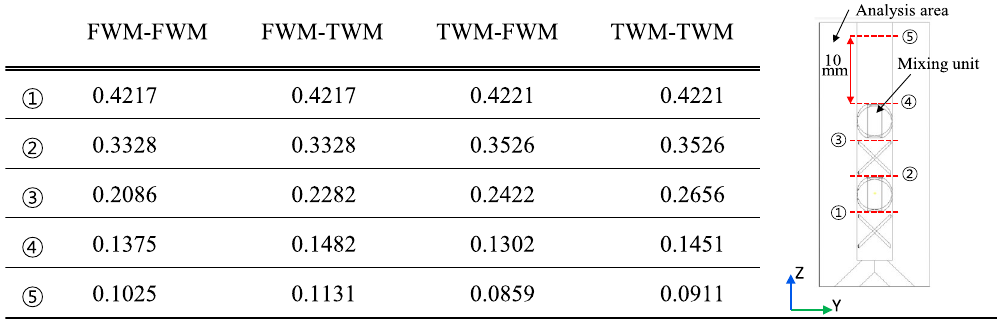
Table 1. Mixing performance ( σ VF , standard deviation of mixing volume fraction) according to